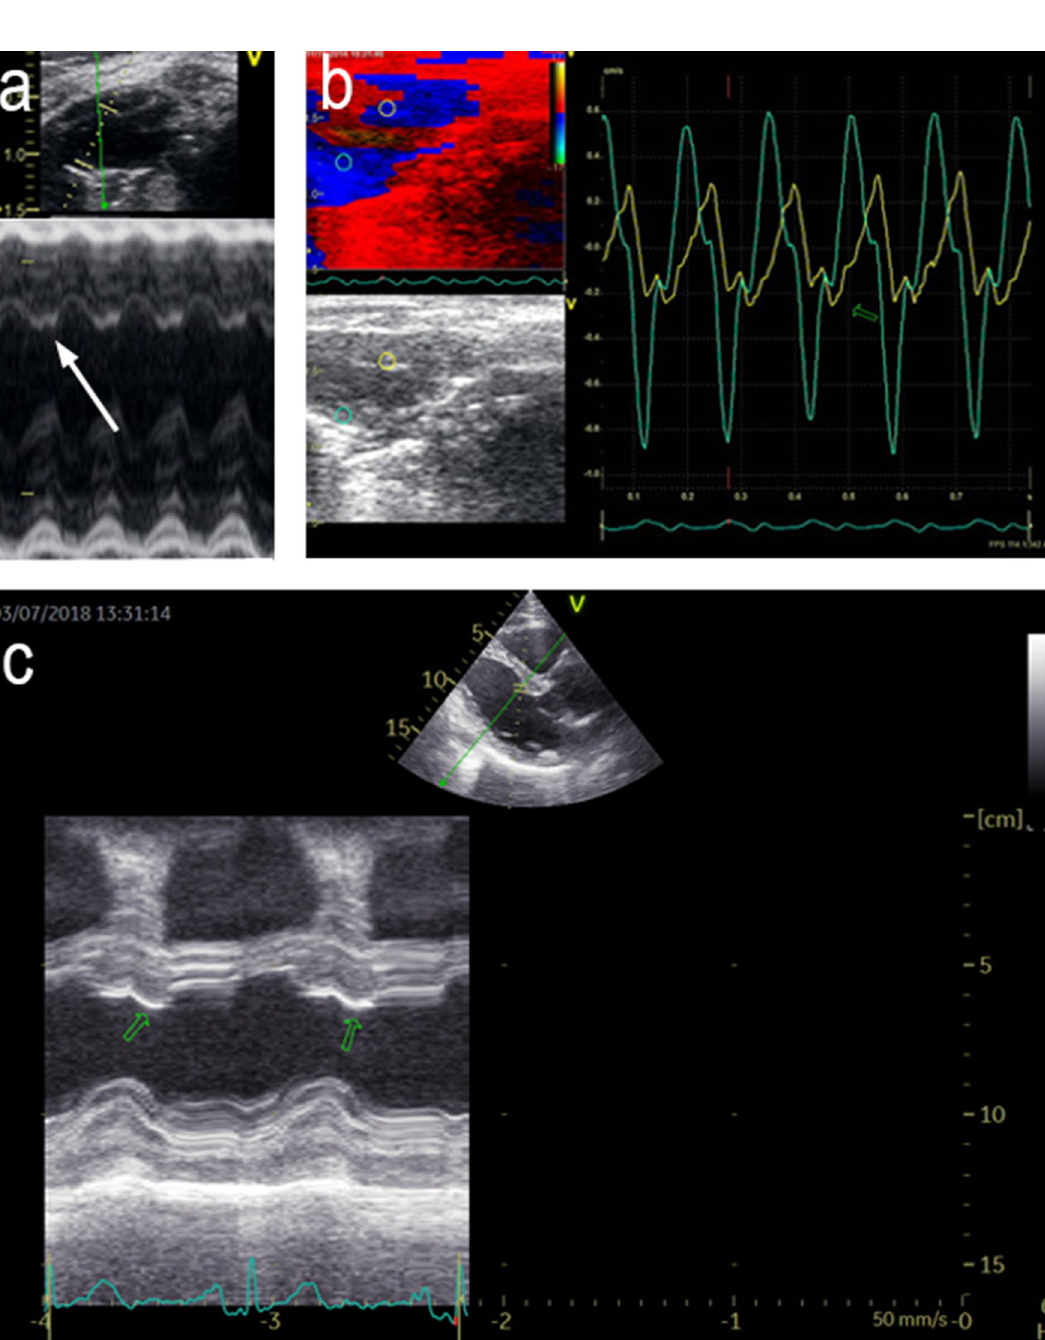
Figure 1. Echocardiographic assessment of PST. ( a , b ) Examples of PST in murine model. ( a ) M-mode of parasternal long axis view. White arrow: PST in the interventricular septum. ( b ) Tissue Doppler Imaging (TDI) of the parasternal long axis view. Green hollow arrows: PST in the interventricular septum (IVS). ( c ) example of PST in patient with MFS. M-mode of the parasternal long axis view. Green hollow arrows: PST in the